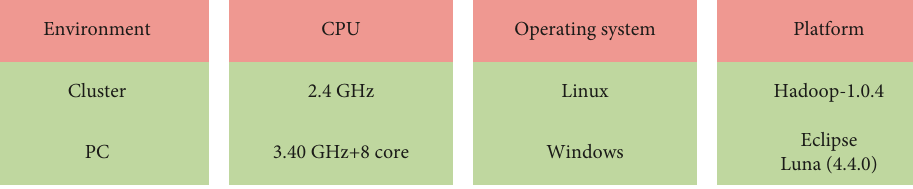
Figure 3: Experimental environment parameters.